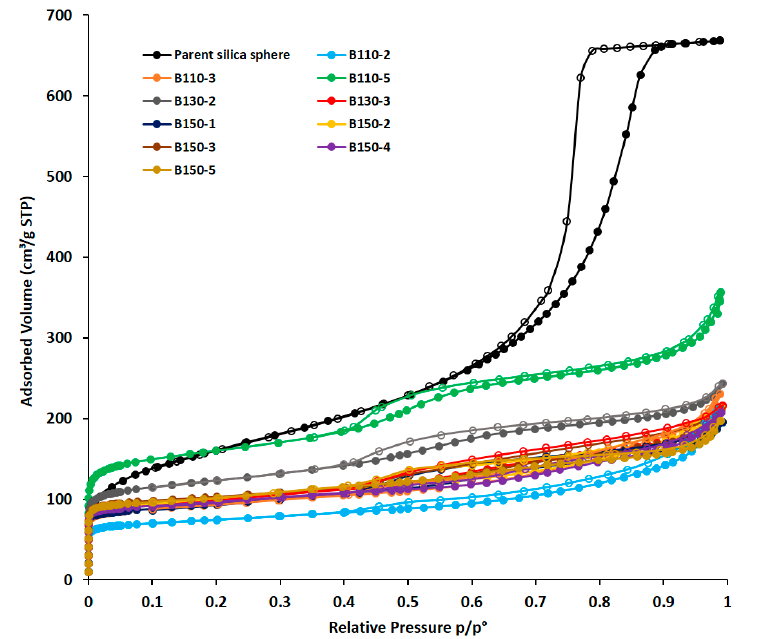
Figure 5. N 2 adsorption–desorption isotherms at –196 °C of the calcined silicalite ‐ 1 beads obtained by pseudomorphic transformation at different temperatures (T) and durations (time) (B ‐ T(°C) ‐ time (days)) compared to the parent silica bead.